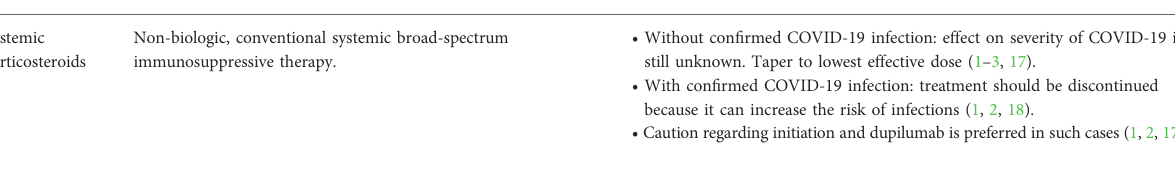
TABLE 1 Summary of current recommendation for nonbiologic and biologic systemic medications in AD treatment. Treatment Mechanism of action Recommendation Systemic corticosteroids